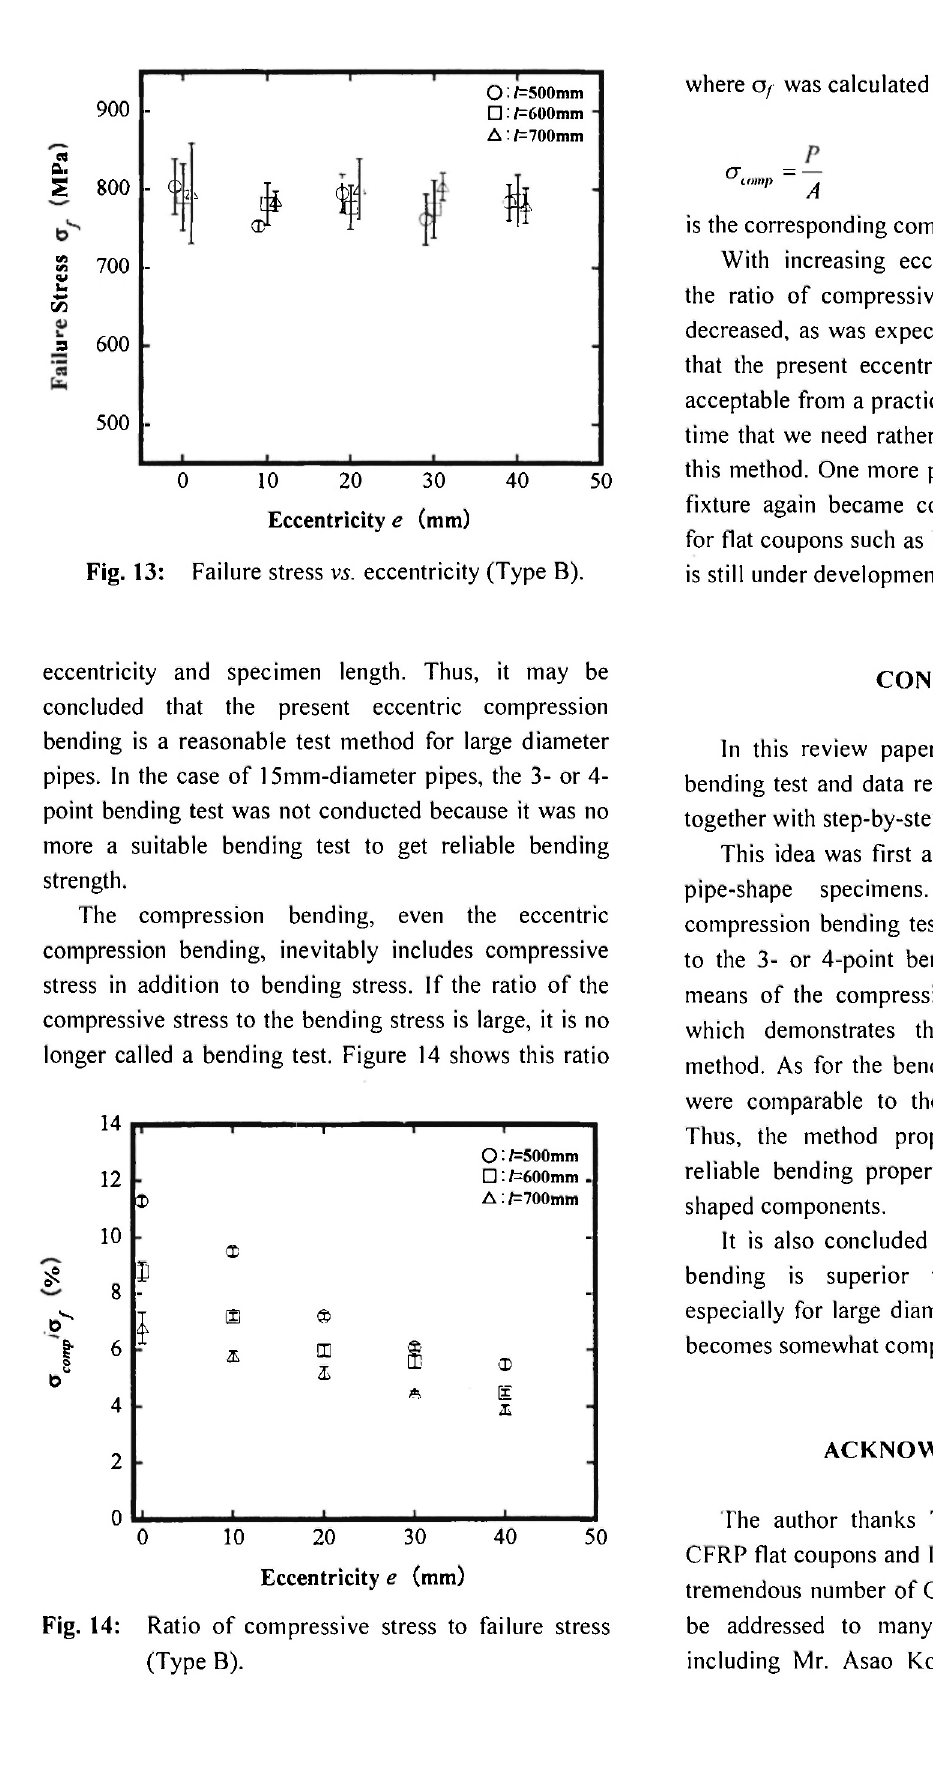
Fig. 14: Ratio of compressive stress to failure stress (Type